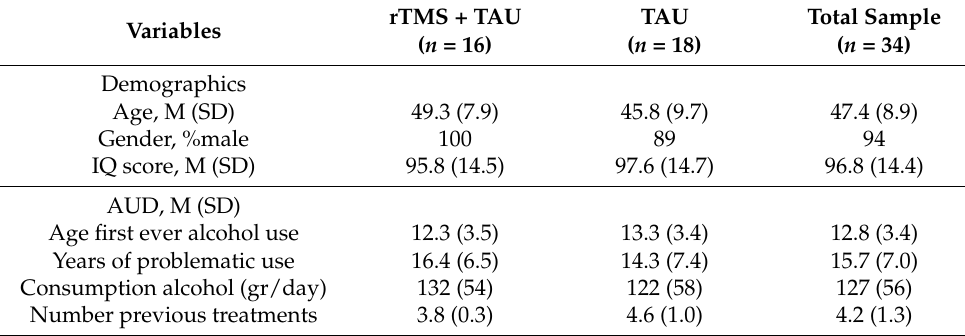
Table 1. Baseline Sample